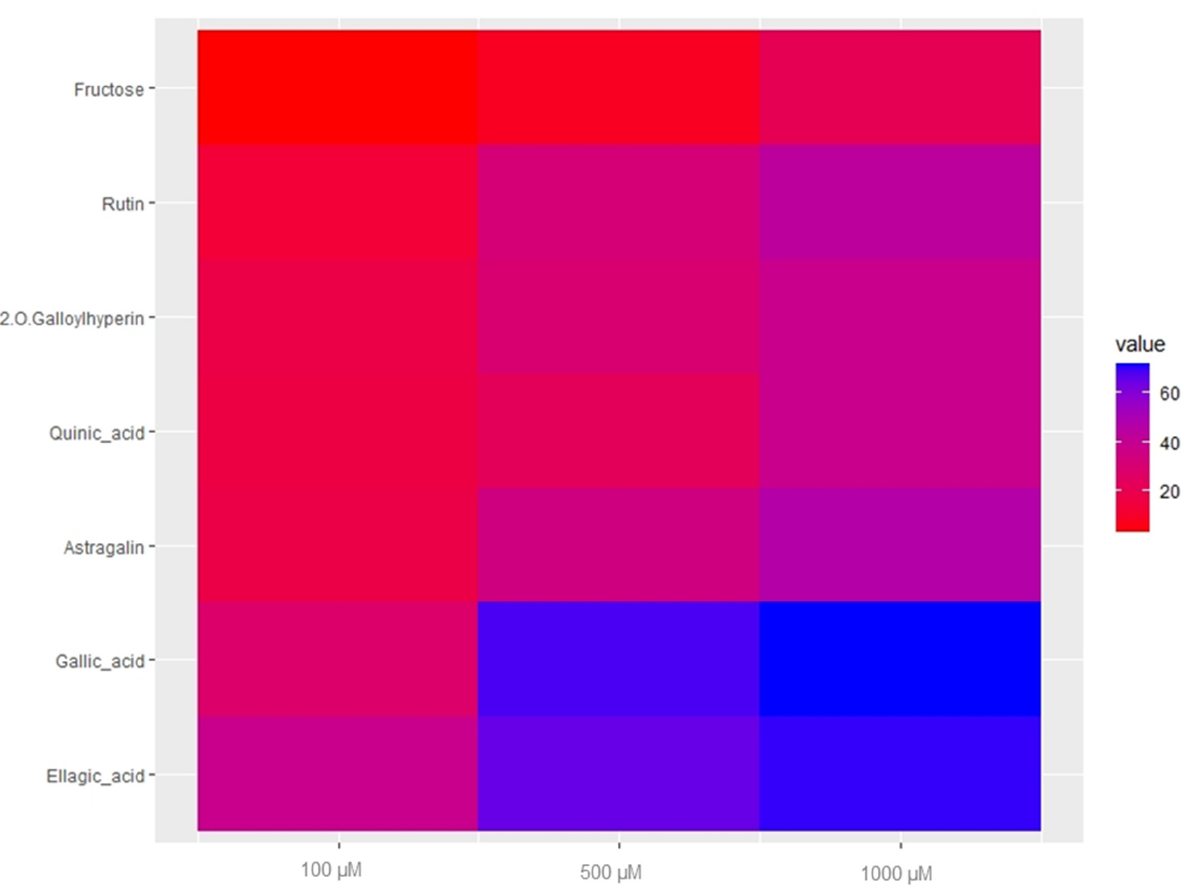
Table 3. Concentration of the major compounds in the two most active fractions.